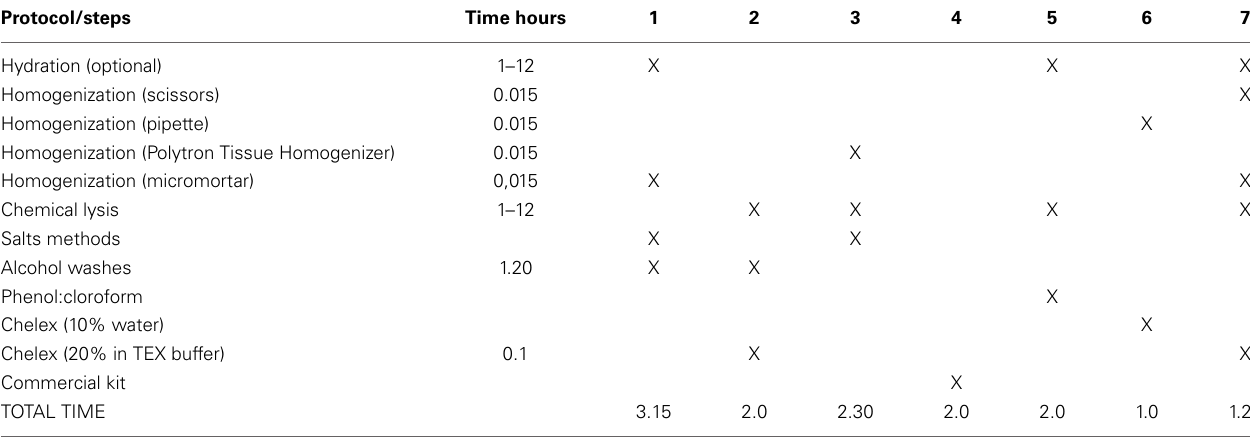
Table 1 | Main steps of DNA extraction.